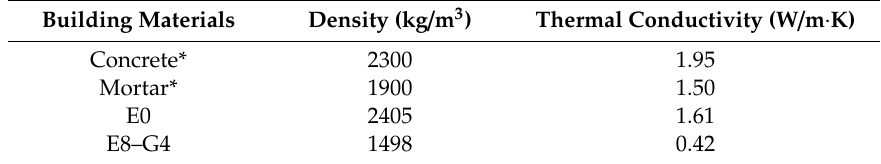
Figure 6. BIM model of the building: ( a ) three-dimensional view of the building and ( b ) building layout. Table 5. Thermo–physical properties of materials used in the building